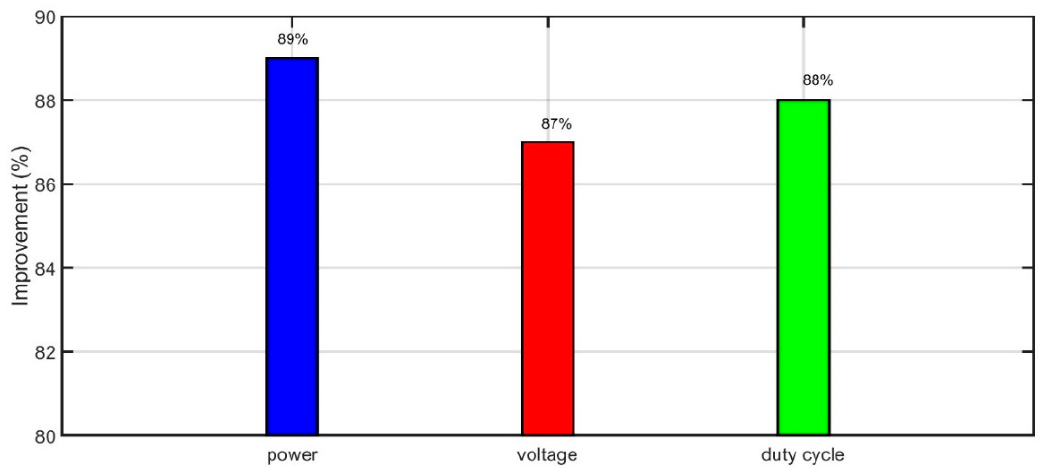
Figure 23. The comparison between the IC method and the IABC method.